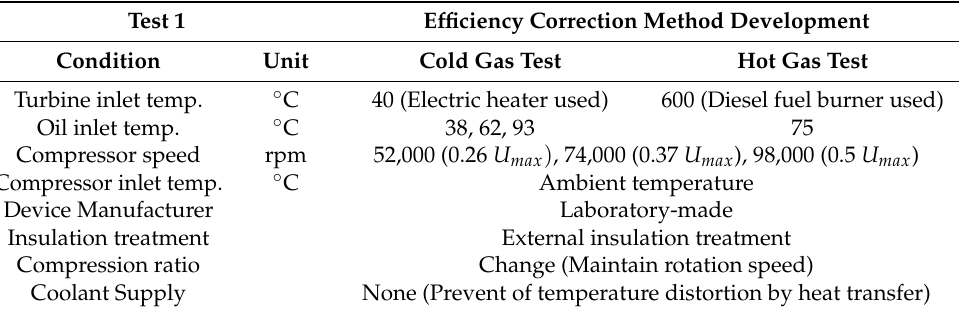
Table 1. Experimental condition of efficiency correction method development.